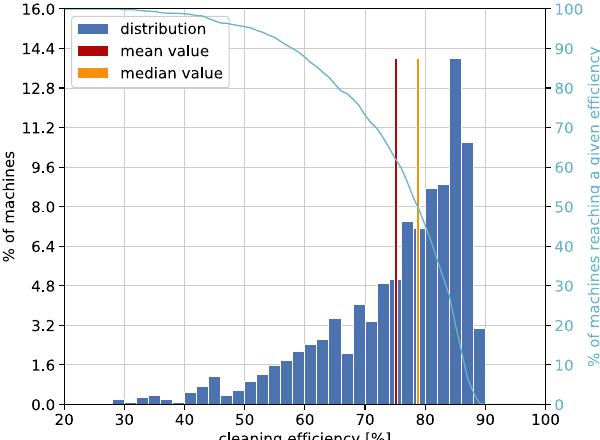
FIG. 12. Global cleaning efficiency distribution for about 1000 random machines with optics